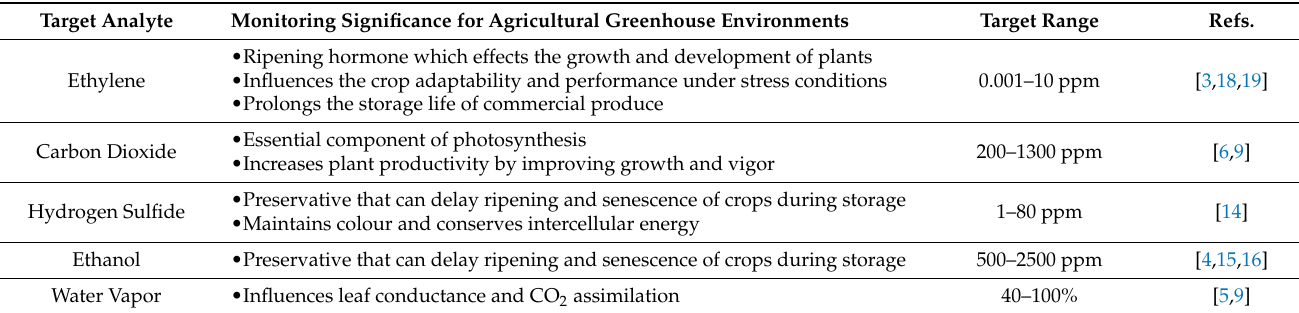
Table 1. Monitoring significance of target analytes in agricultural greenhouse